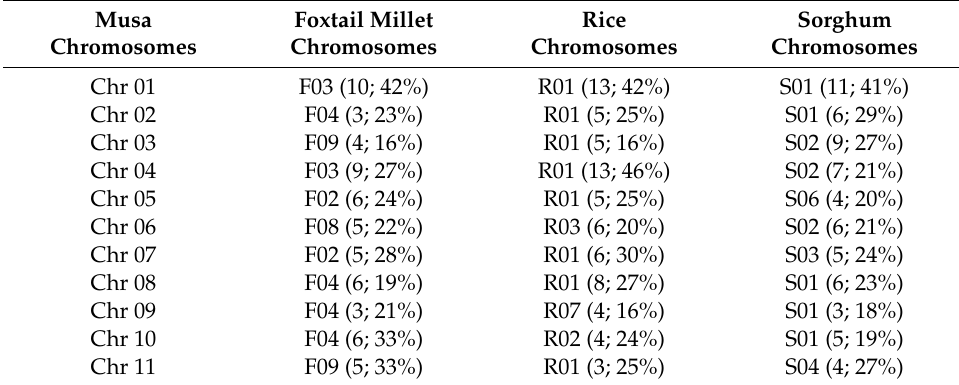
Table 3. A summary of functionally related microsatellite marker-based comparative mapping showing maximum syntenic relationships of the chromosomes of M. acuminata with those of foxtail millet, rice and